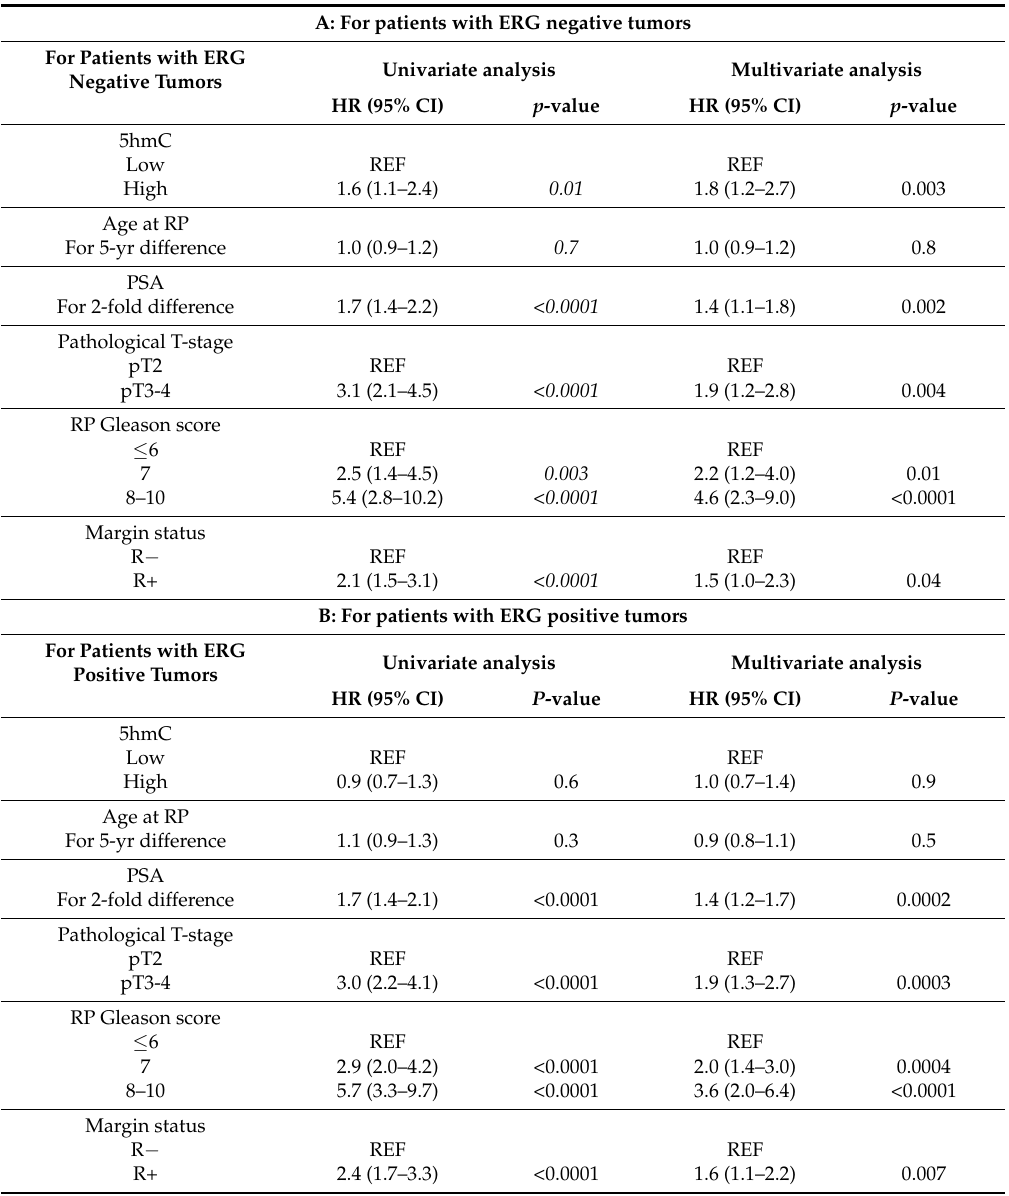
Table 2. Uni- and multivariate cause-specific Cox regression of biochemical